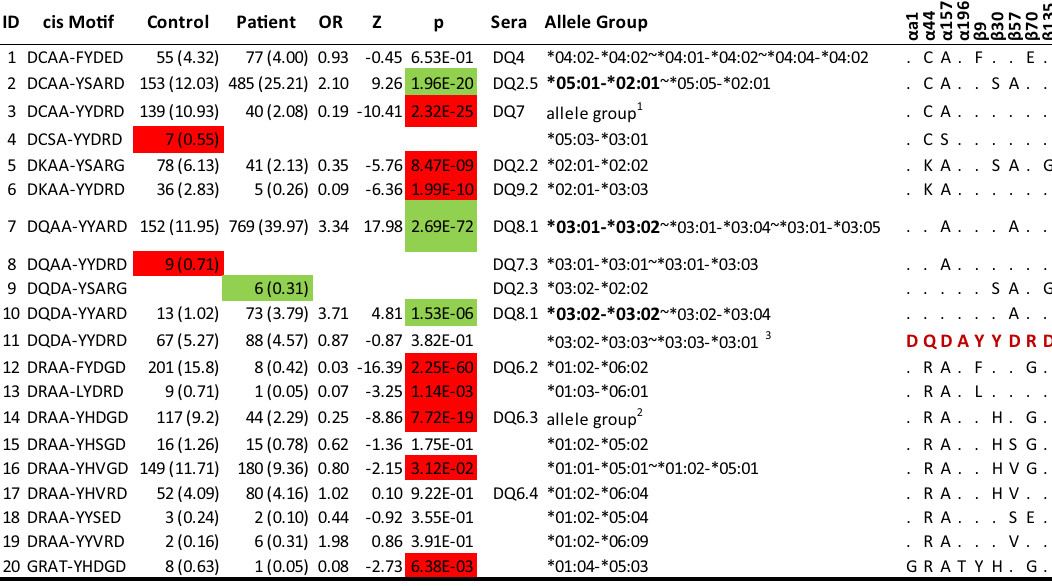
Table 2. Allelic association analysis of type 1 diabetes with DQA1-DQB1 motifs of (αa1, α44, α157, α196, β9, β30, β57, β70, β135): estimated frequency (%) among control and patient, estimated odds ratios, Z-score, and p-value, corresponding serotype, and equivalent allelic groups, in addition to profiles of amino acids across all motifs Five rare motifs, with fewer five observed motif copies, are excluded. In total we have 1266 and 1921 motif copies observed in 636 controls and 962 patients, respectively, after excluding 6 and 3 motif copies from respective